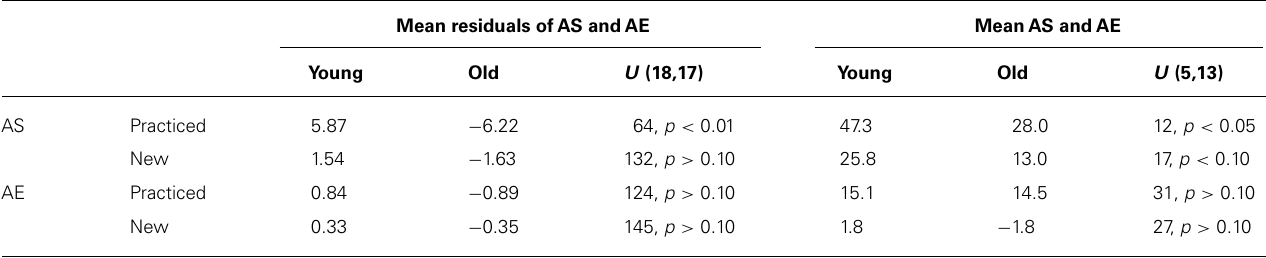
Table 2 |Age-related variations of residuals of adaptive shifts (AS) and after-effects (AE) after regressions on explicit shifts (left half) and ofAS andAE in subgroups without explicit knowledge (right half). Mean residuals ofAS